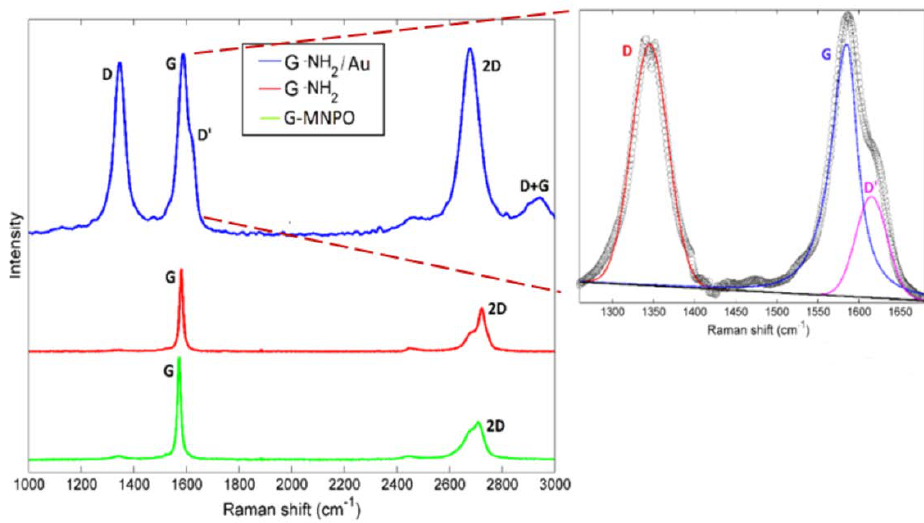
Figure 7. Raman spectra of G-MNPO, G-NH 2 , G-NH 2 / Au; the deconvolution of the D and G bands of the G-NH 2 / Au is reported in the inset.